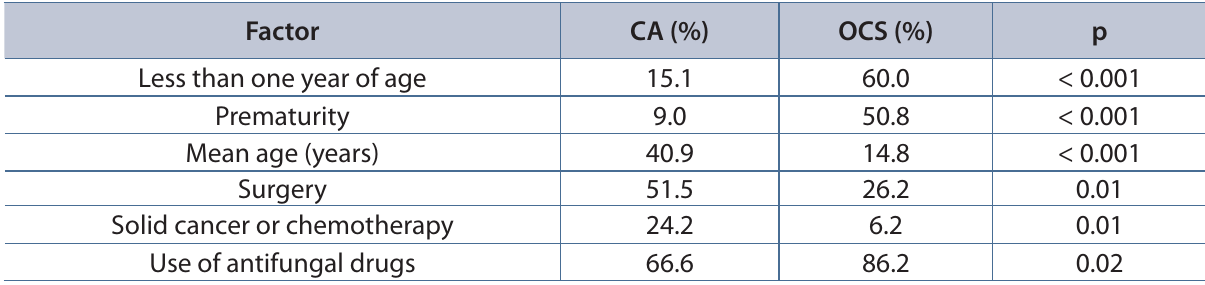
Table 5. Factors associated with candidemia caused by C. albicans (CA) and other Candida species (OCS) in